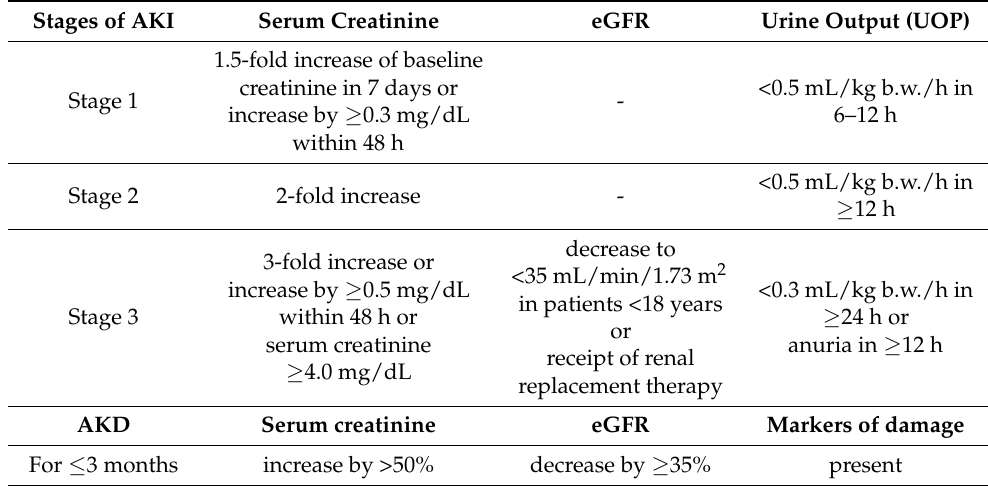
Table 1. KDIGO acute kidney injury (AKI) and acute kidney disease (AKD) definitions [7,8]. eGFR, estimated glomerular filtration